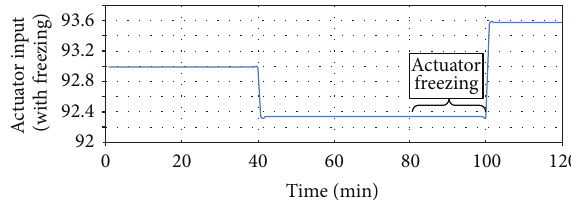
Figure 4: Simulated actuator fault by introducing freezing at the time interval (80–100 minutes).